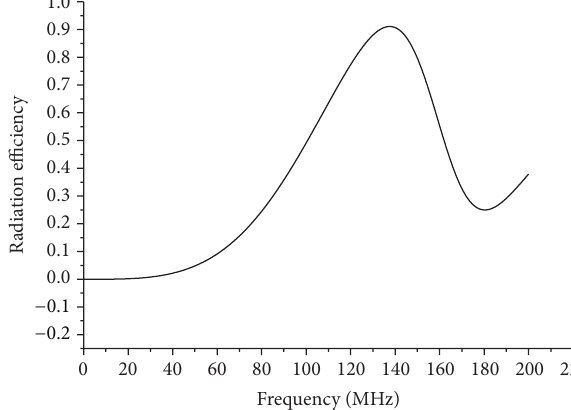
Figure 4: The radiation efficiency values of proposed antenna for WPT against